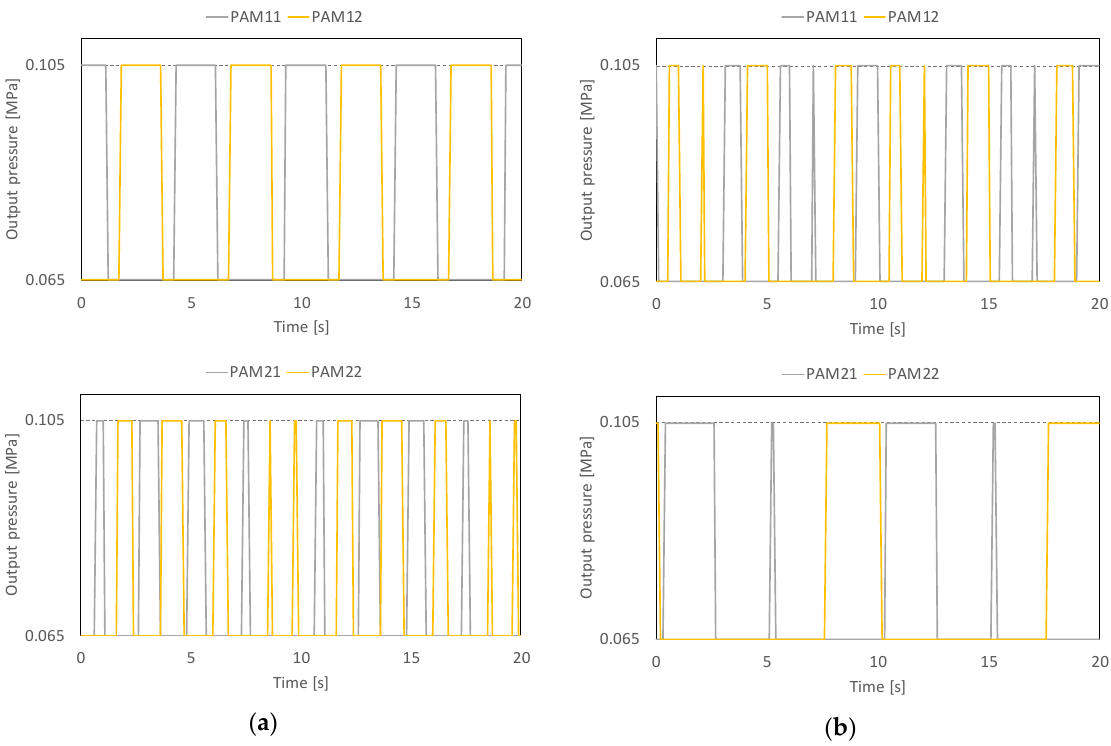
Figure 21. Cyclic inputs of PAMs using evaluation function 3 with 0.5 kg (( a ) first generation, ( b ) 18th generation).